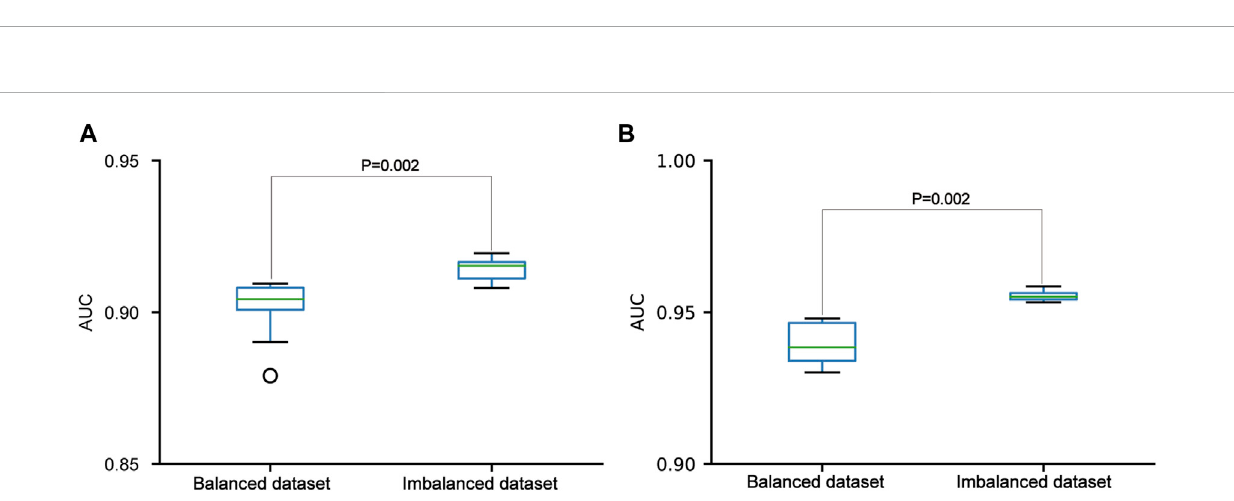
FIGURE 6 Performance comparisons between the CNN OH models based on balanced and imbalanced datasets in the independent test dataset. The models were developed for the pSADPr-pS dataset (A) and the pSADPr-UM dataset (B) .